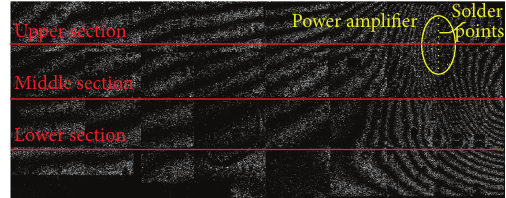
Figure 11: Whole 𝑢 -displacement map of the